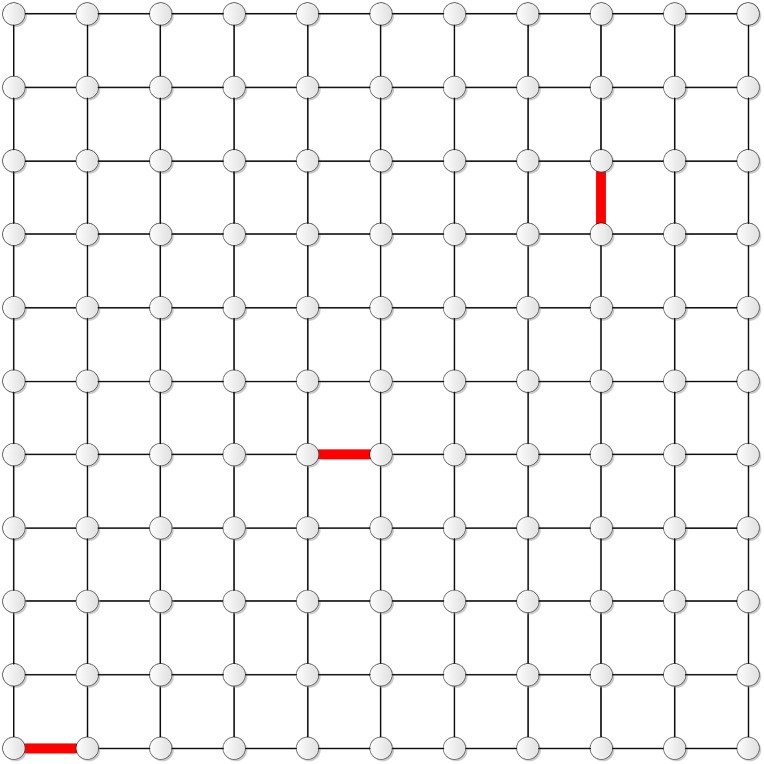
The distribution of the three edges in T11.